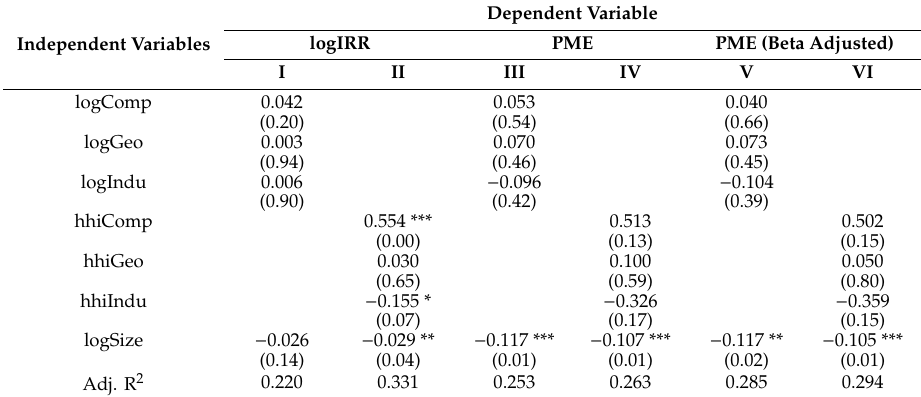
Table 4. Results from ordinary least squares (OLS)